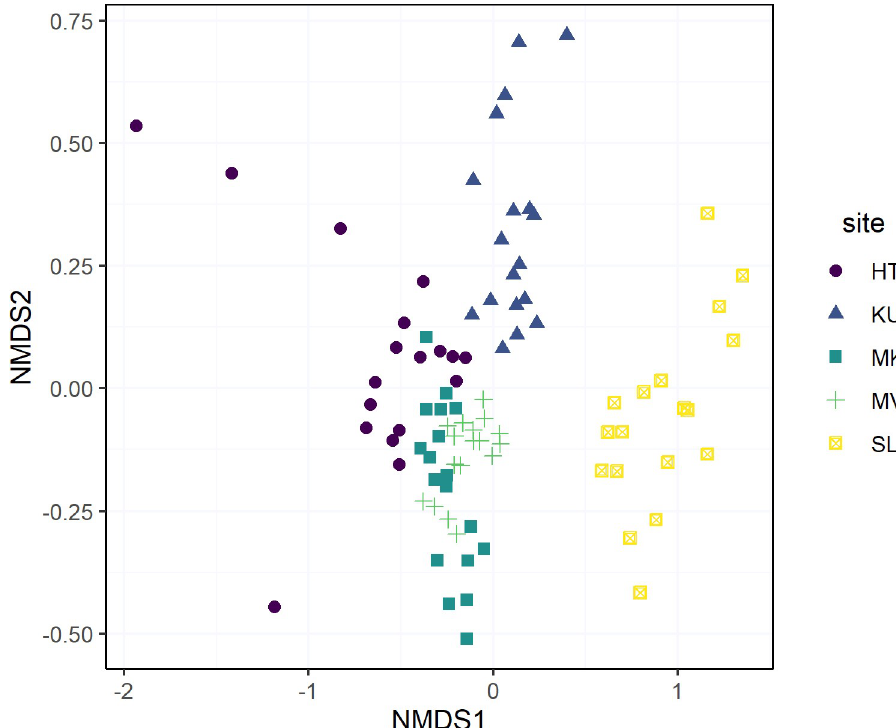
Fig 3. Nonmetric multidimensional scaling (NMDS) showing the community structure of the m ā nuka phyllosphere microbiome across sites. Distance based on Bray-Curtis dissimilarity. The stress value of the NMDS plot is